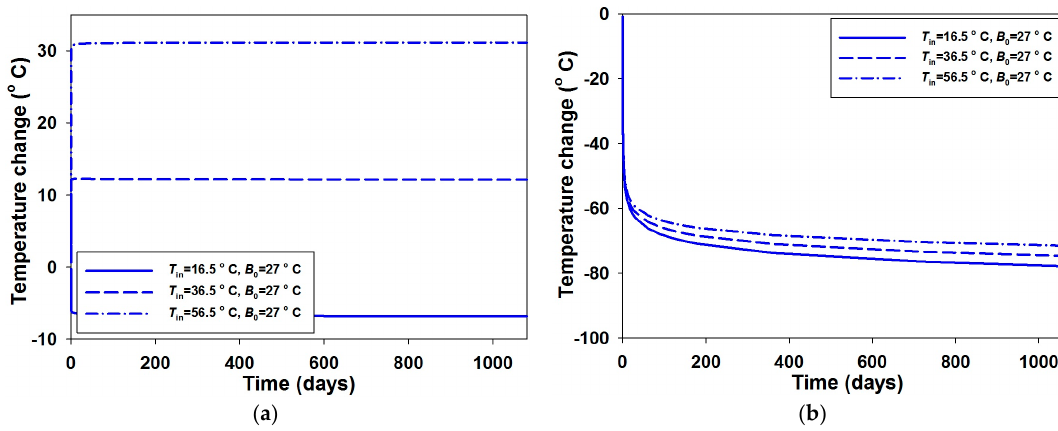
Figure 4. ( a ) Outlet temperature change and ( b ) bottom-hole fluid temperature change for a range of injection fluid temperatures with Q d = Q a = 23 Kg/s.